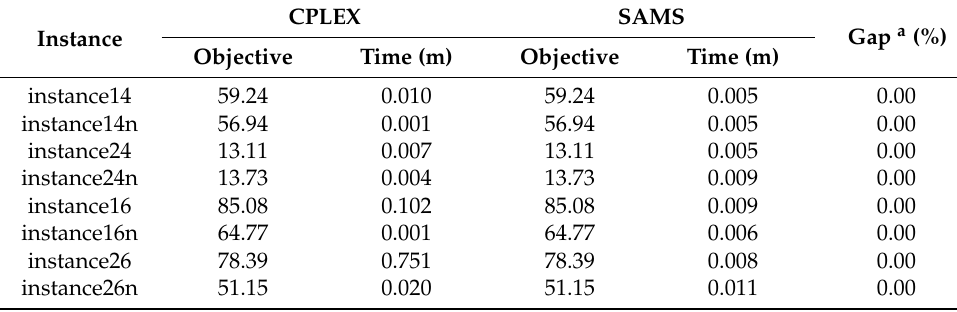
Table 1. Comparison between CPLEX and proposed SAMS solution for SARPFC.